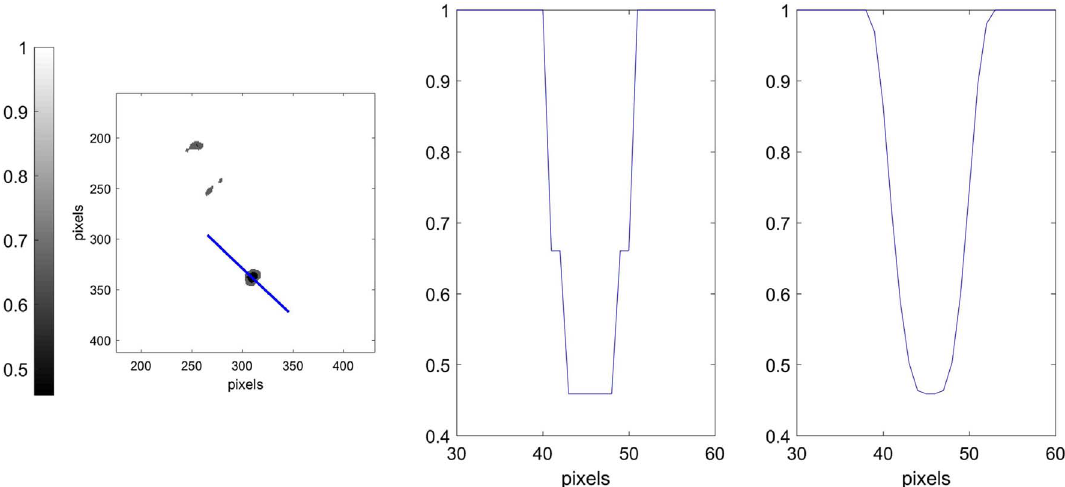
Fig. 8. Left panel: the image shows the mask W j ð t Þ of the observed active region. The blue line shows the location of pixels where the mask intensity pro fi le is calculated; central panel: intensity pro fi le of the mask corresponding to the blue line; right panel: same pro fi le after the Gaussian smoothing. The abscissas of the plots reported in the central and right panels are in pixels. The pro fi le range (displayed by blue line in the left panel ) is 20 pixels.